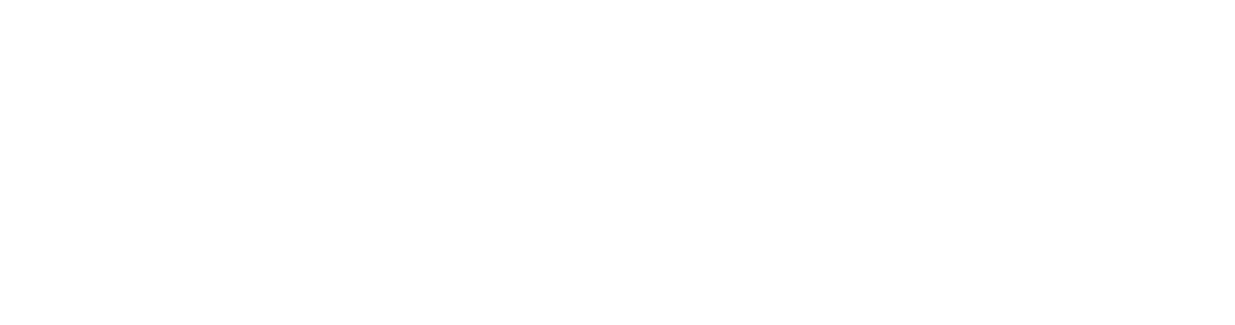
Frontiers in Cellular Neuroscience